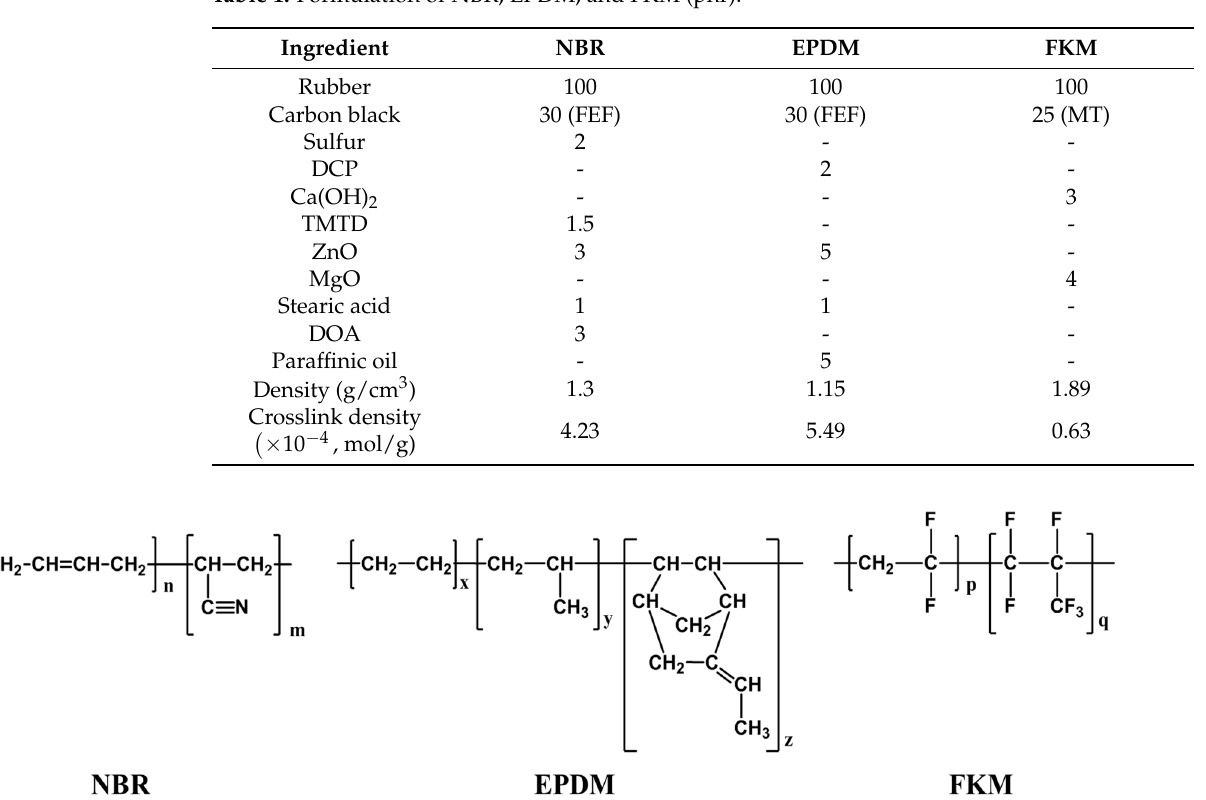
Figure 1. Chemical structure of NBR, EPDM, FKM.